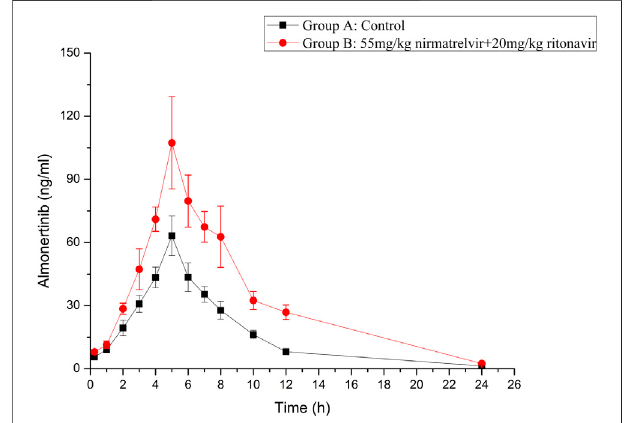
FIGURE 3 | Mean plasma concentration-time curve of almonertinib in differenttreatment groupsofrats.GroupA:thecontrolgroup(0.5% CMC-Na) and Group B: 55 mg/kg nirmatrelvir and 20 mg/kg ritonavir (n = 6, Mean ± SD).